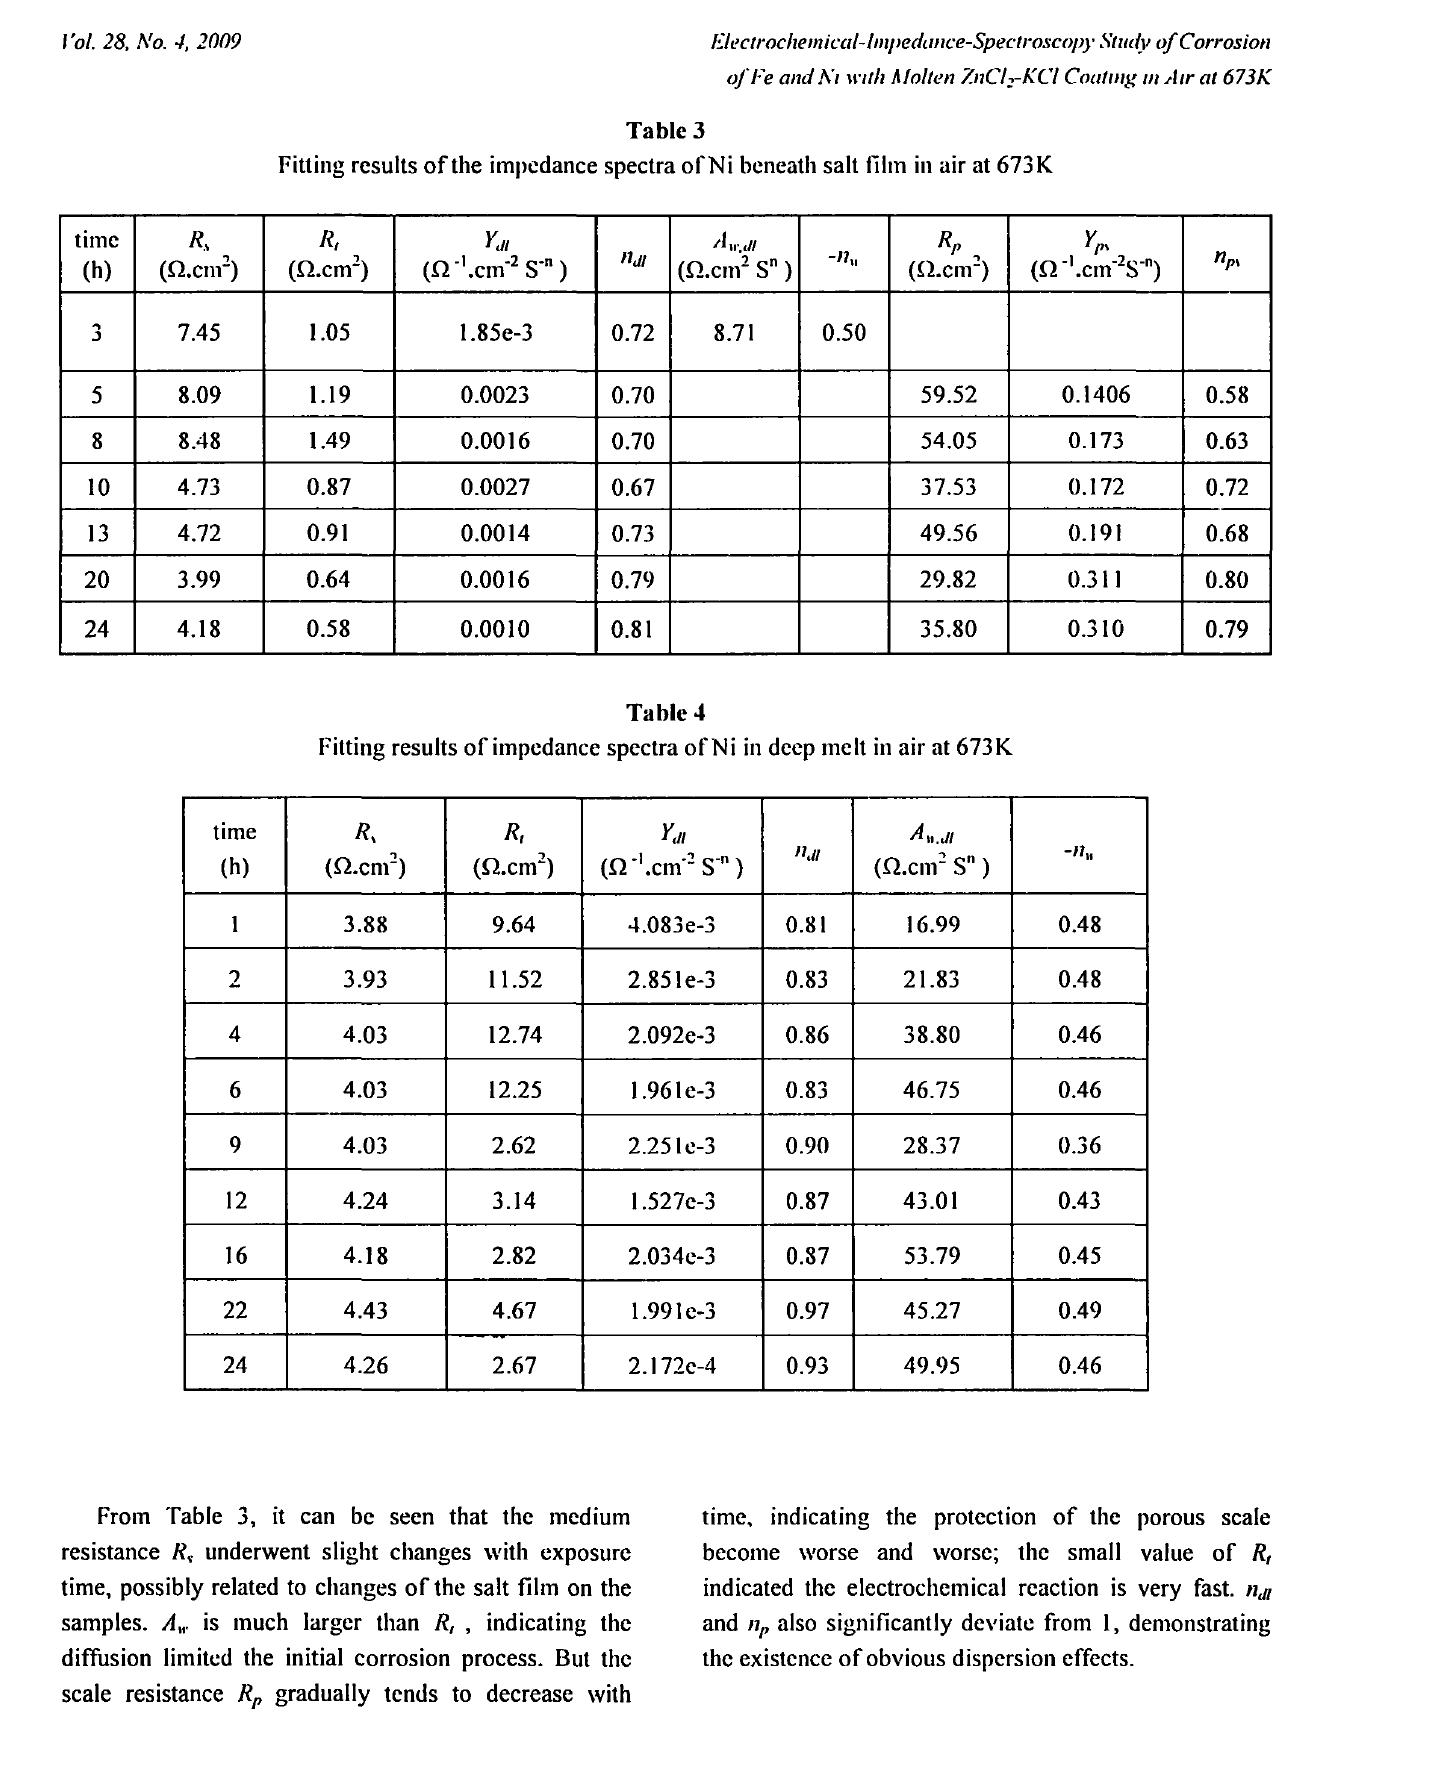
Fitting results of impedance spectra of Ni in deep melt in air at 673